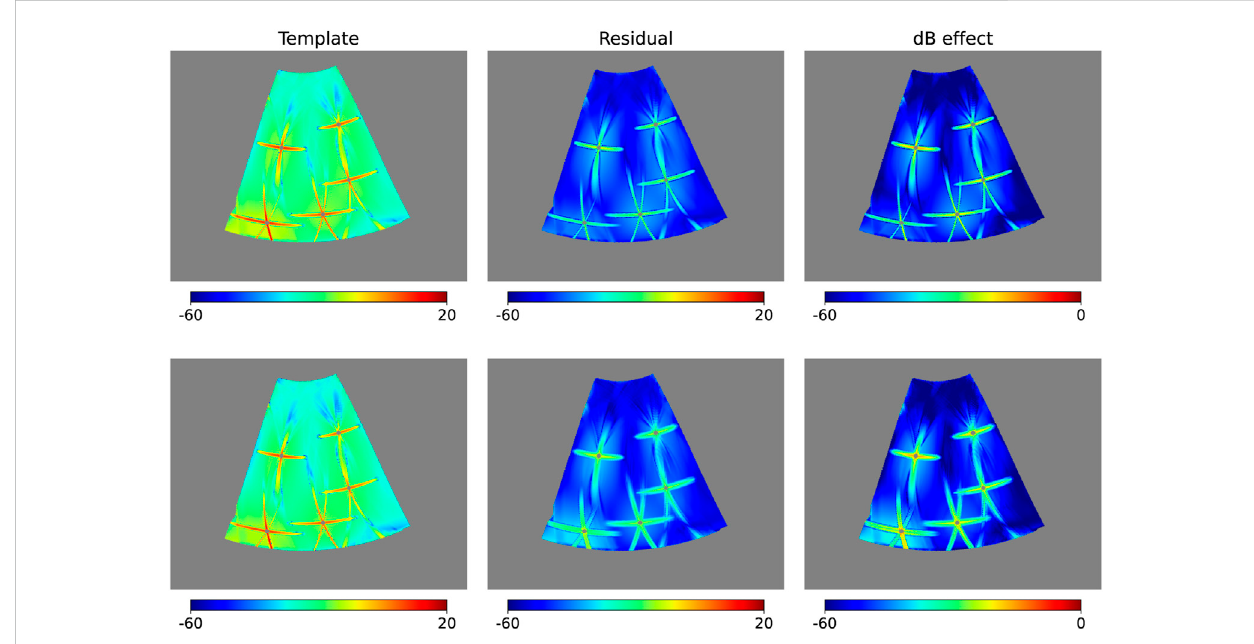
FIGURE 3 SameasinFigure1,butforthecaseofmultiplepointsourceswithunknownpolarizationdirectionwhen r =0.023,wheretheresidualsareestimated through Eq. 15.